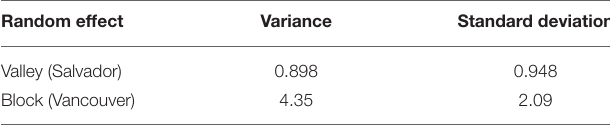
TABLE 3 | Variance and standard deviation of the random effects (of the intercept) for the Vancouver and Salvador full